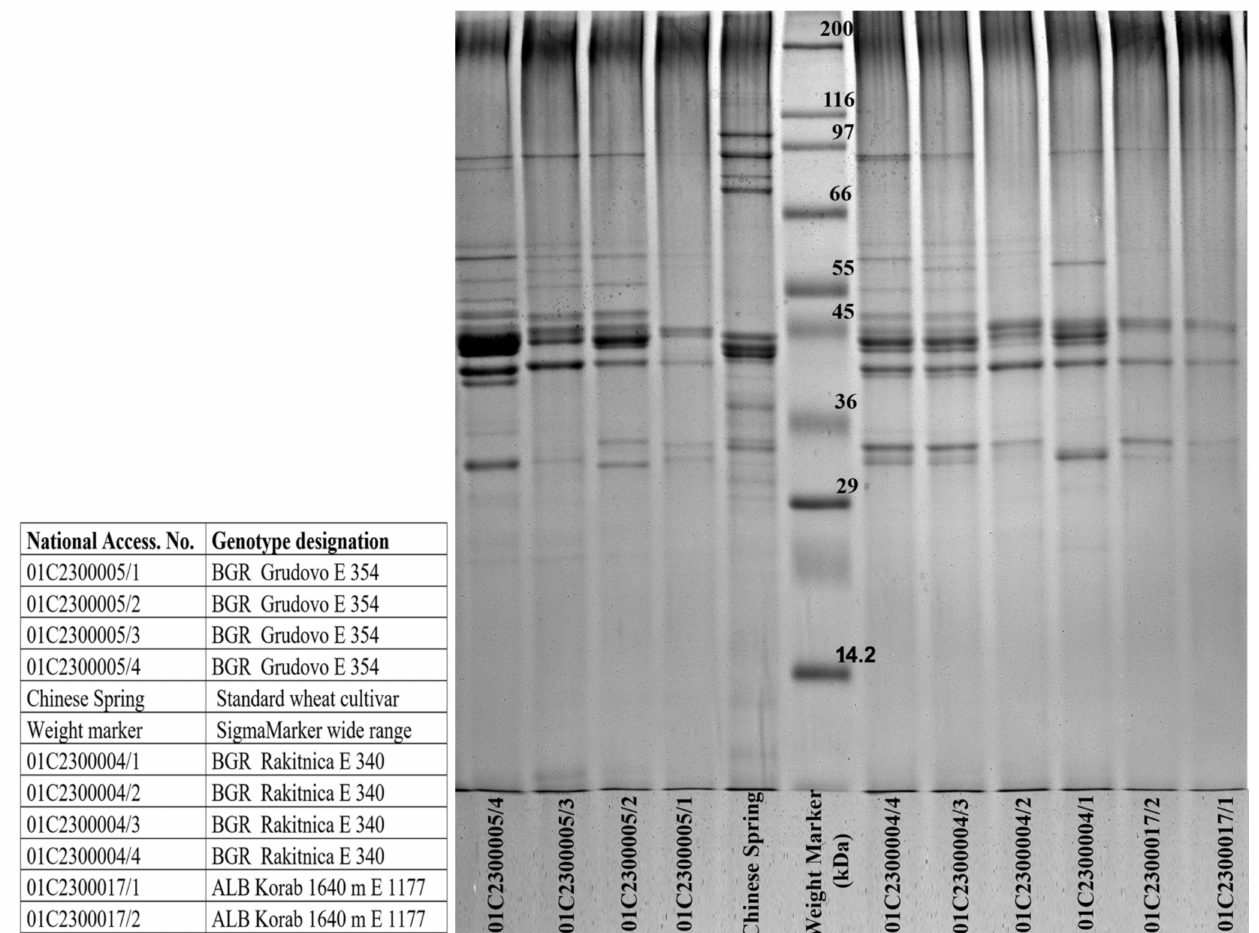
Figure 3. The examples of intra- and inter-population variability of HMW- (70–116 kDa) and LMW- (29–66 kDa) glutelins in 3 collected populations of Dasypyrum villosum including comparison with model common wheat cultivars